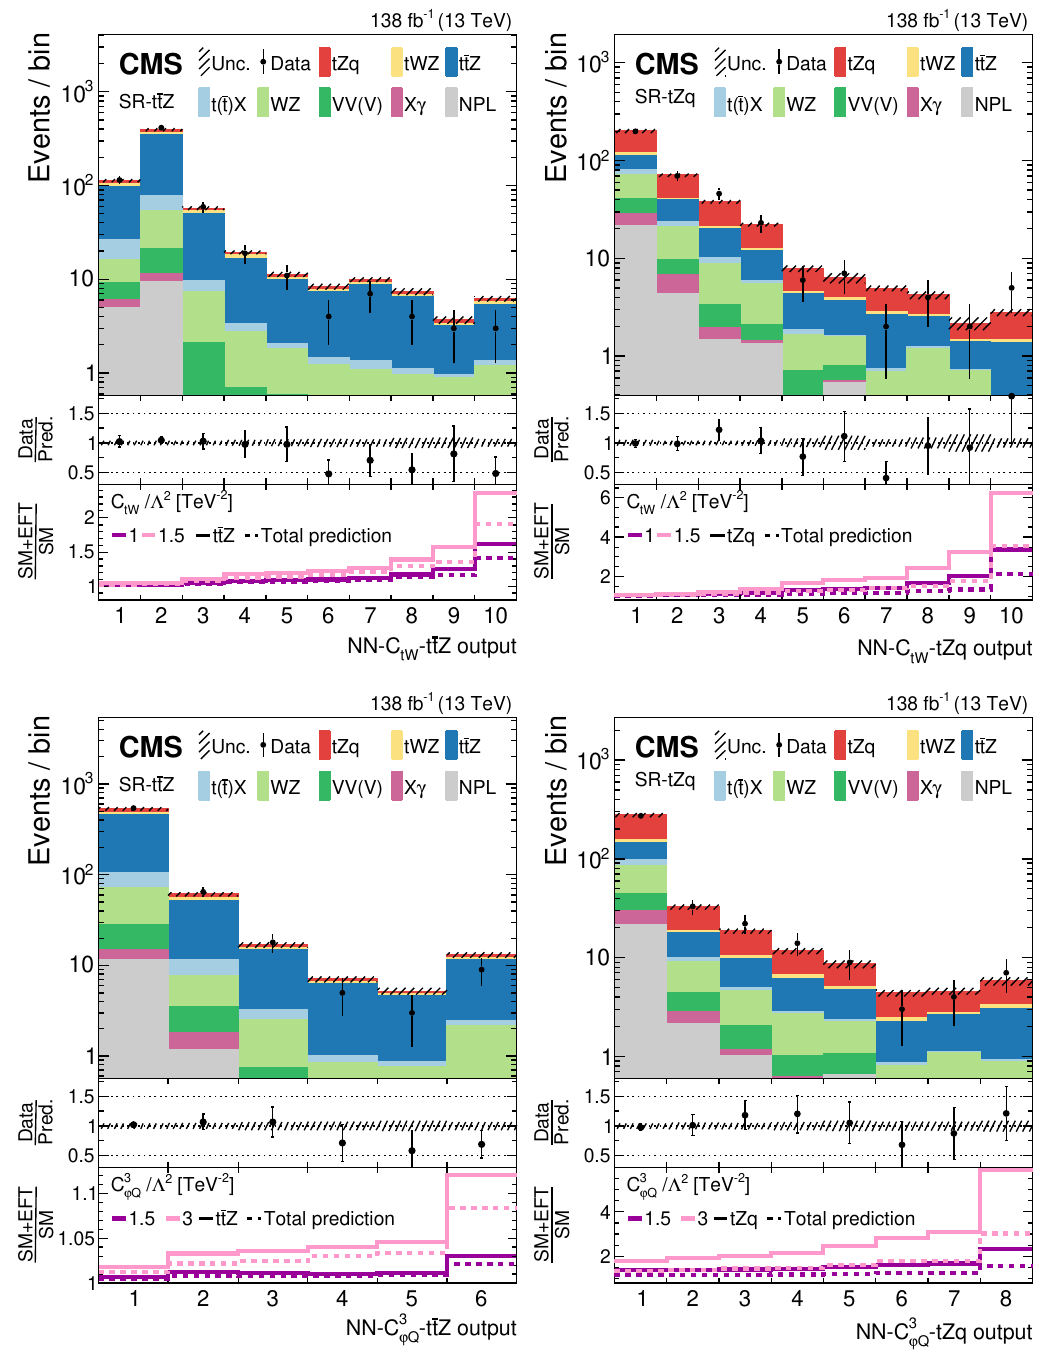
Figure 6 . Post-fit data-to-simulation comparisons for the distributions used in the SR- ttZ (left) and SR- tZq (right), for the 1D fits to c (upper) and to c 3 (lower). The middle panels display tW ϕ Q the ratios of the observed event yields to their post-fit expected values. For each region, the lower panel shows the change of the event yield in each bin with respect to the SM prediction for two benchmark EFT scenarios, both for the main signal process in the region (thick lines) and for the total prediction (dashed